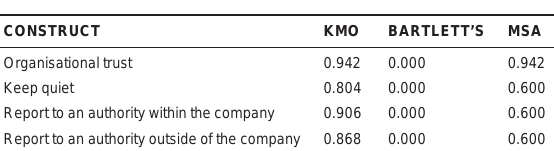
taBle 1 Results of diagnostic